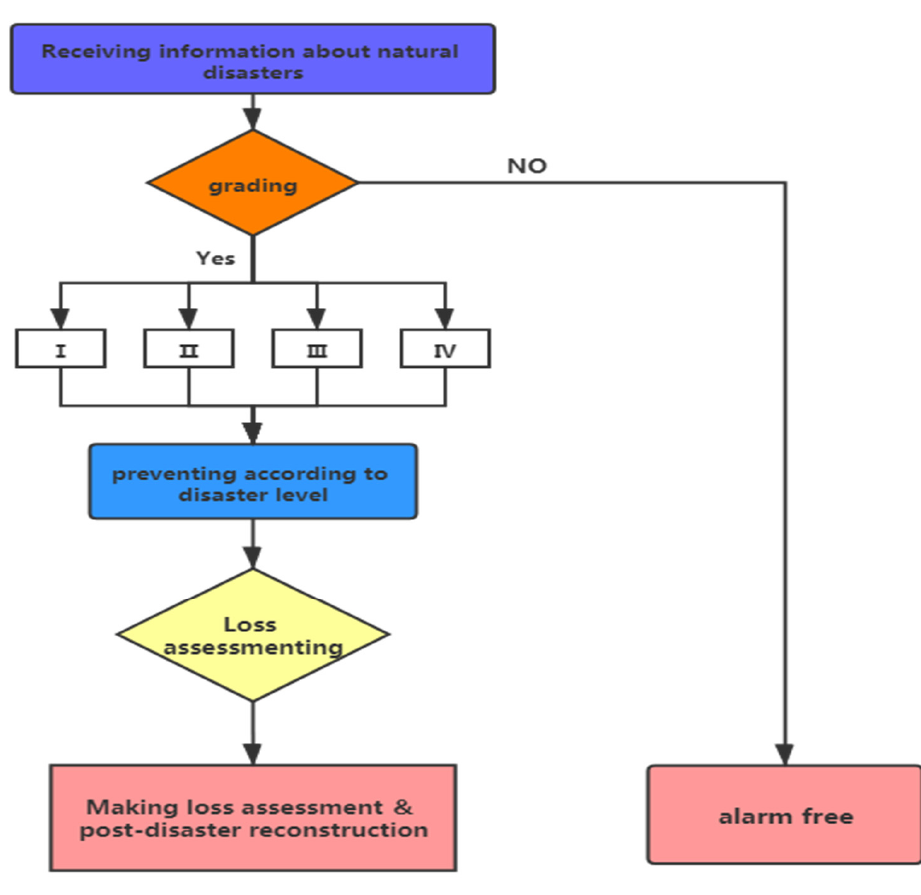
Table 10. The broken chain theory.